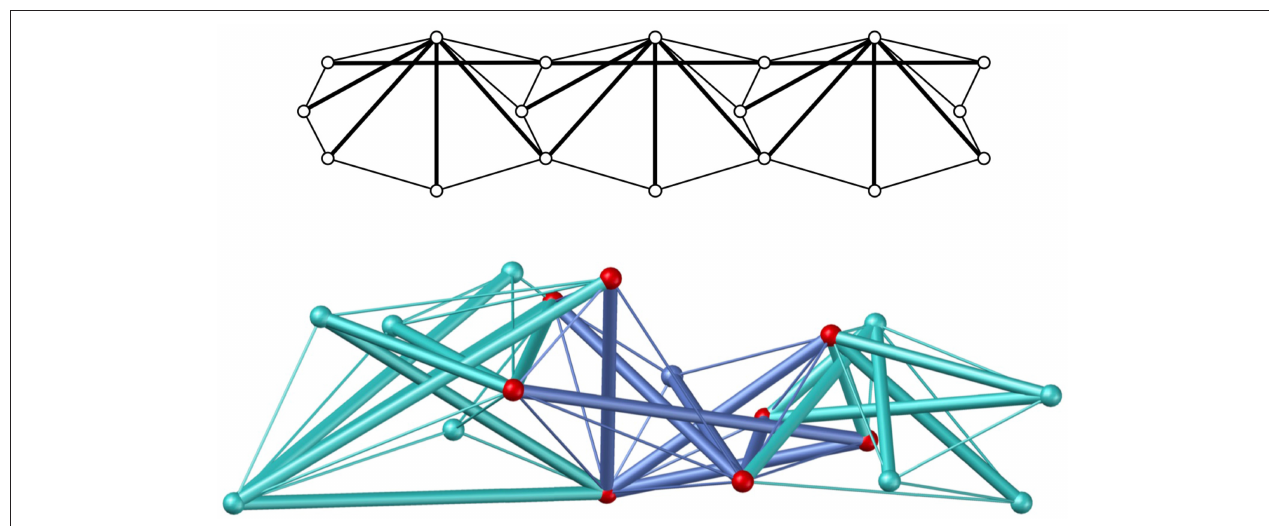
FIGURE 15 | (Top) A modular universally rigid framework in E 2 obtained by repetition of a universally rigid module. (Bottom) Construction of a modular universally rigid framework in E 3 for randomly generated nodal positions. The framework is composed by three universally rigid subframeworks (depicted in different color), each sharing four nodes with the adjacent